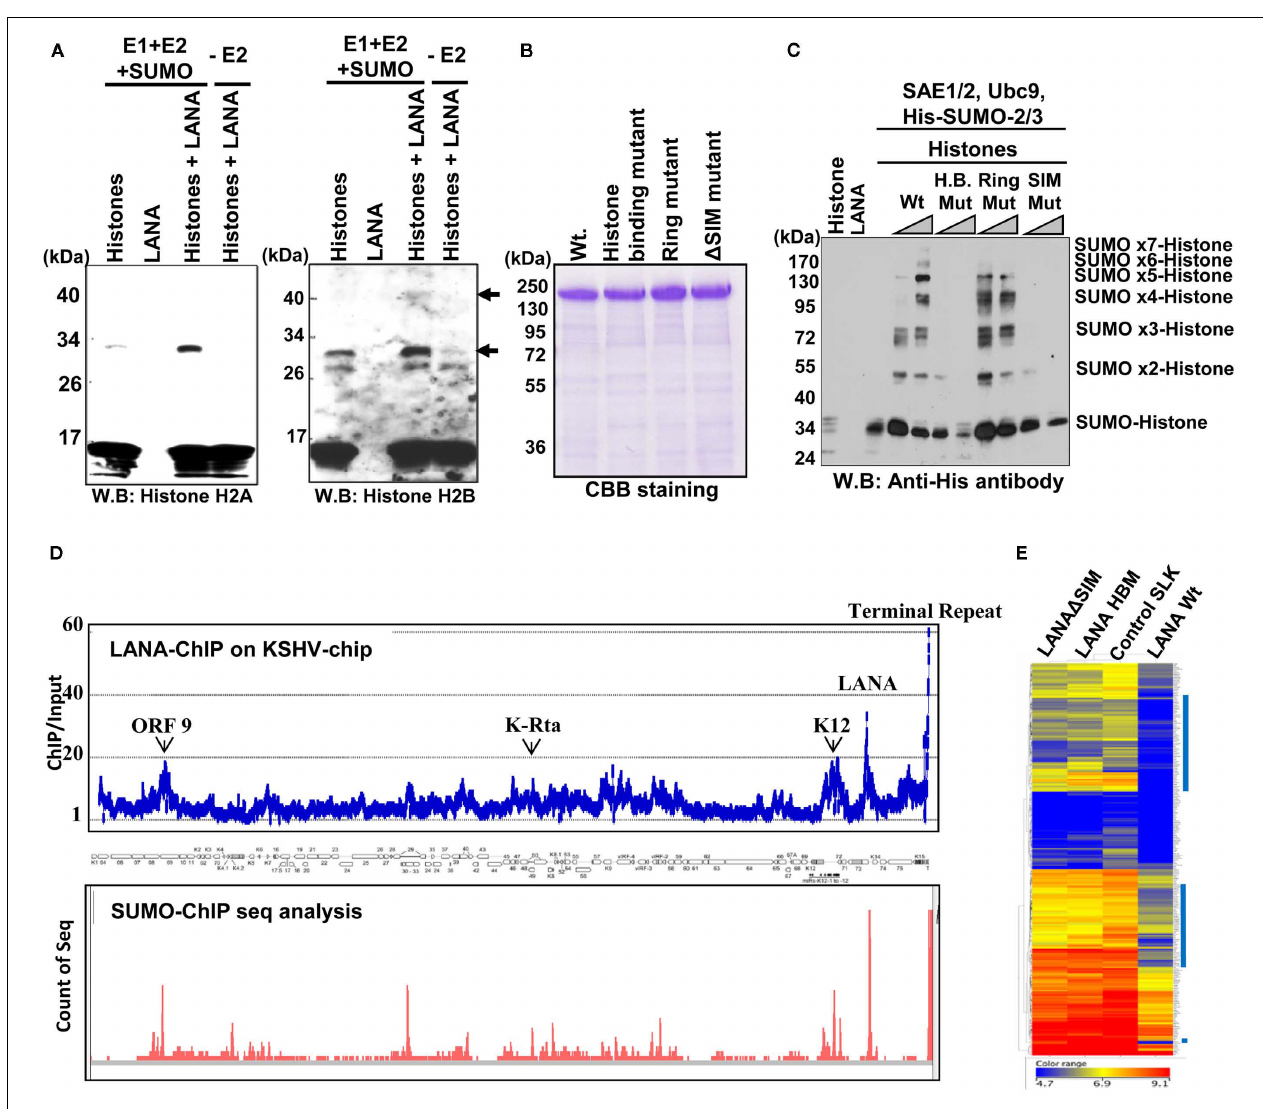
FIGURE 5 | Latency-associated nuclear antigen enhances histone sumoylation in vitro and in vivo . (A) LANA enhances histone H2A and H2B SUMO-modification in vitro .The in vitro SUMO conjugation reaction was performed with purified histone octamer (5 μ g; Roche) as a substrate. SAE1/2 (E1, 50nM), Ubc9 (E2, 50nM), and HA-SUMO-2 (50 μ M) were incubated in reaction buffer containing 1mM ATP and MgCl 2 with or without a catalytic amount of LANA (50nM). In the presence of LANA, H2A, and H2B SUMO-modification is enhanced.The arrows indicate SUMO-modified histones, which were increased in SUMO-reaction mixtures supplemented with LANA (three lanes from left). Full-length LANAWt and mutant proteins were prepared with recombinant baculoviruses (B) and used as an E3 SUMO-ligase for in vitro SUMO conjugation reactions. CBB, Coomassie brilliant blue. (C) Histone binding domain and SUMO-interacting motif of LANA are necessary for its SUMO-ligase function. LANAWt but neither